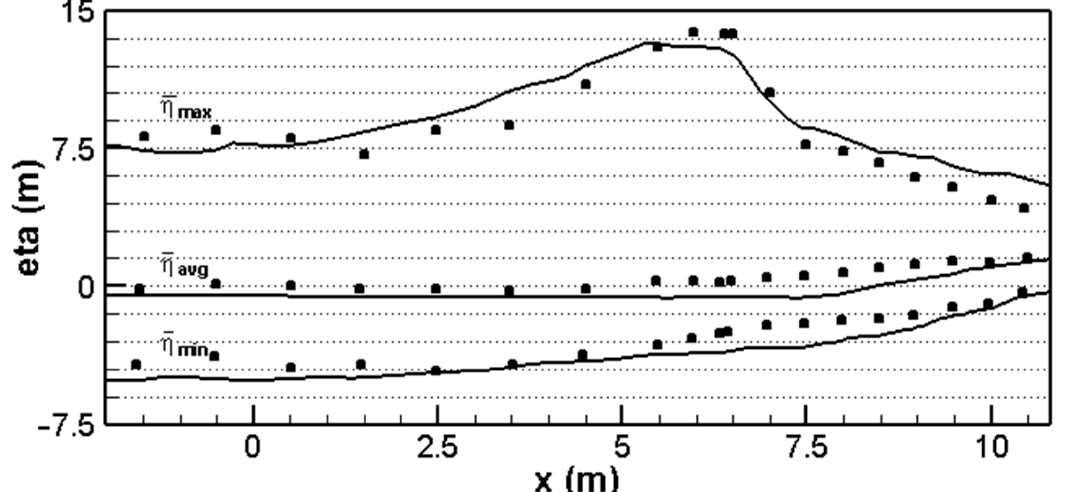
Figure 11. Results 5: minimum, average and maximum water surface elevations in Configuration WK., showing numerical results (solid line) and experimental measurements (circles) [3].